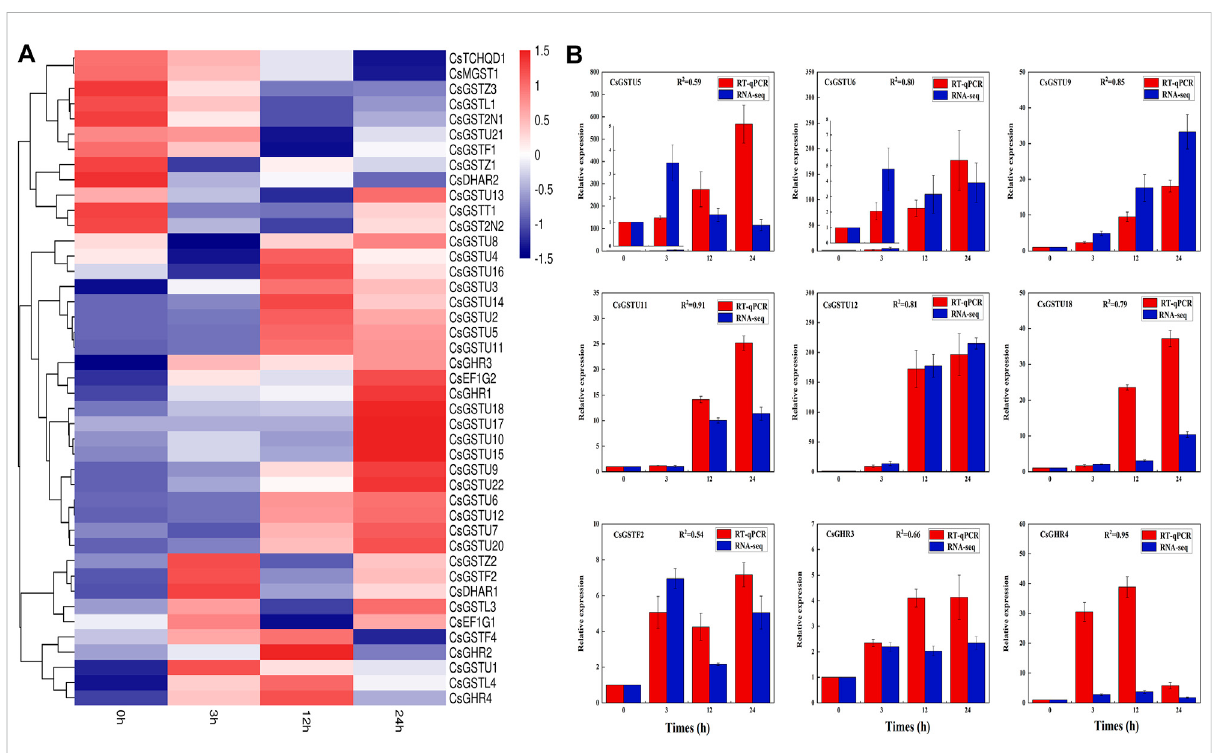
FIGURE 4 CsGST gene expression pattern and transcriptome validation in cucumber under cold stress. (A) CsGST genes that responded to cold stress wereidenti fi edfromRNA-seq data;0 hwasconsidered thecontrol.Redand bluerepresent upregulated anddownregulatedgenes,respectively. (B) Validationoftranscriptomedataandexpressionofcucumberleaf CsGSTsundercoldstress.Expression analysis wasperformedusingRT-qPCR.The expression of CsGSTs at 0 h was considered the control used for normalization. The values were analyzed from three biological replicates and represent means ± SE. R 2 represents the correlation coef fi cient between RNA-seq and